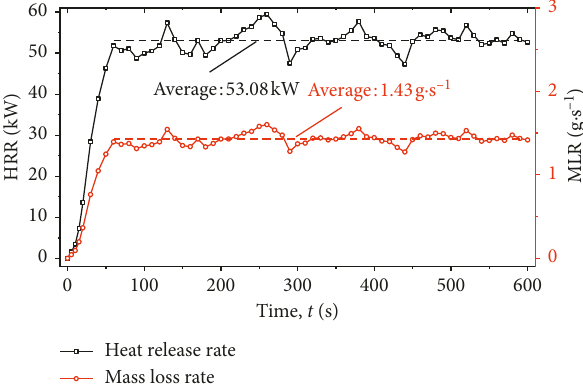
Figure 4: The evolution of the HRR as function of